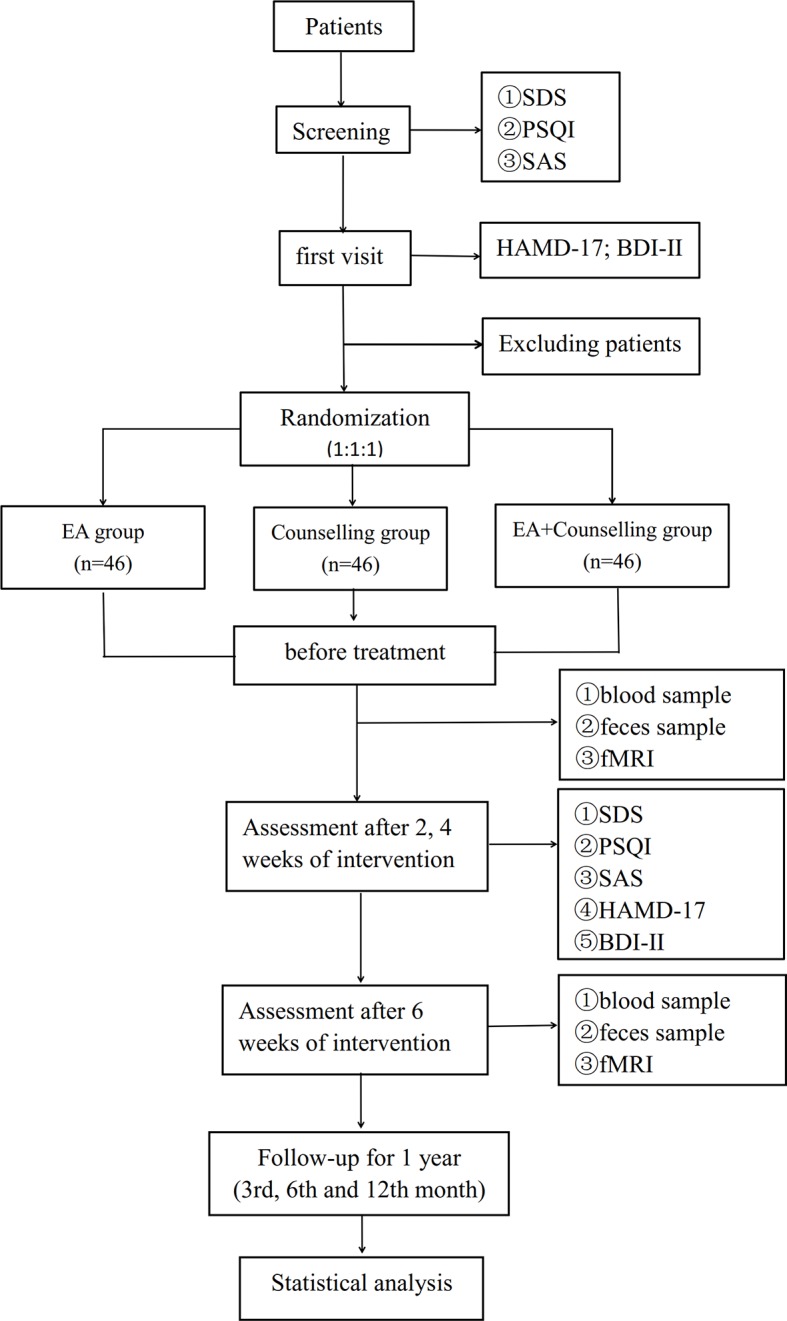
Flow chart of study design.